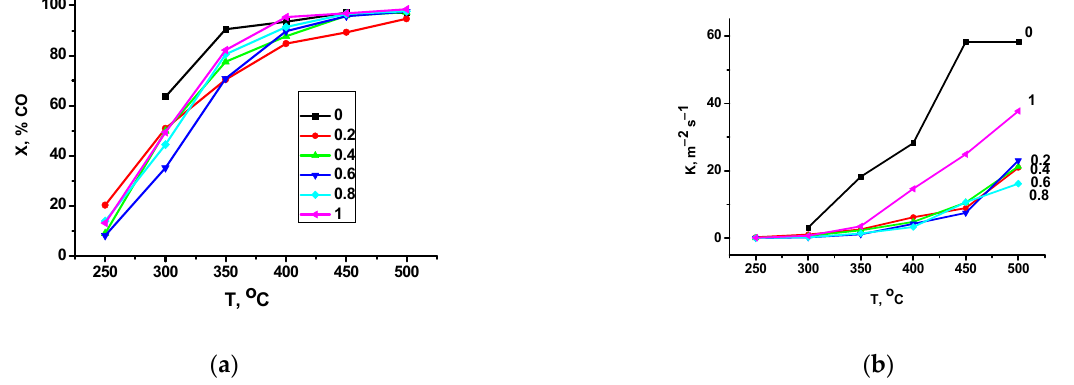
Figure 7. Temperature dependence of CO conversion ( a ) and CO oxidation rate constant ( b ) for LaMn 1 − x Fe x O 3 perovskites.